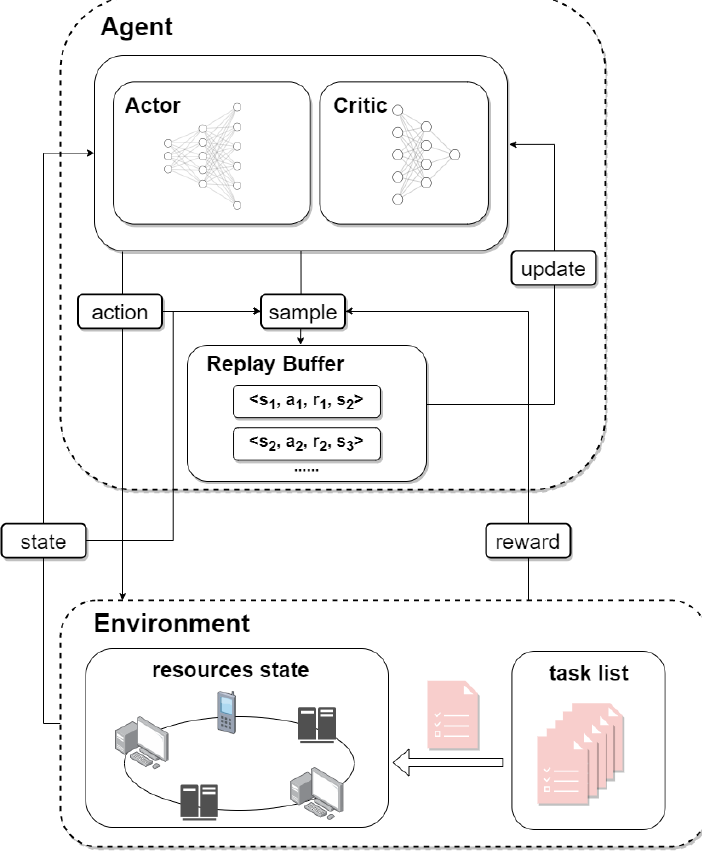
Figure 3. Resource-scheduling algorithm framework based on